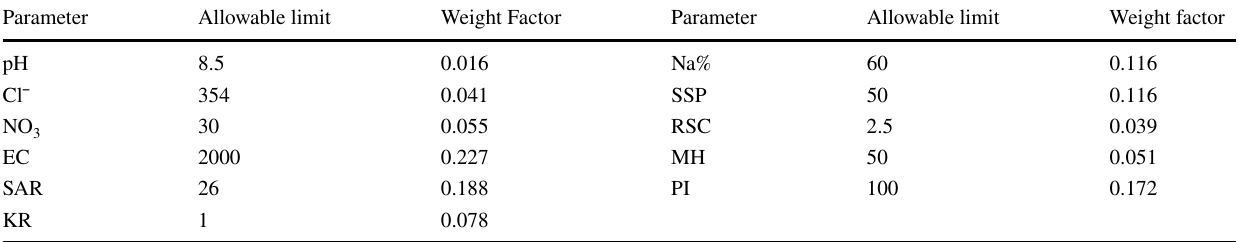
Table 5 The values calculated of relative weight ( W i ) of various irrigation water quality parameters and the permissible standard values notified by to (Kelley 1941; Richards 1954; Wilcox 1955; SZABOLCS 1964; Todd and Mays 1980; Ayers and Westcot 1985; WHO 2011)